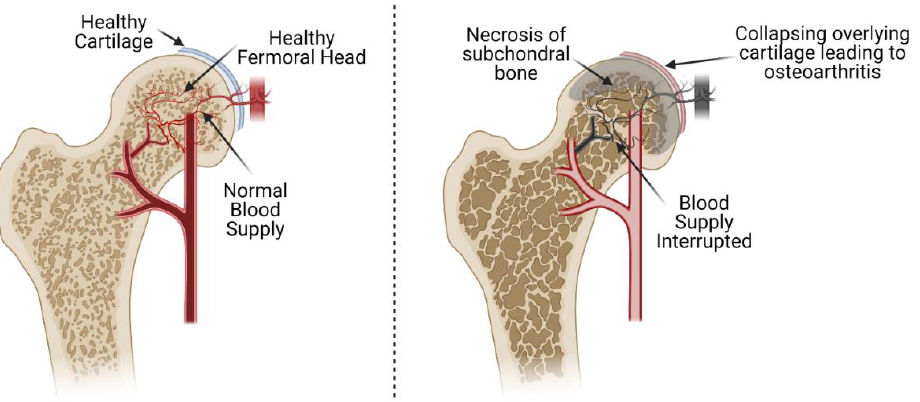
Figure 1. Avascular necrosis of the femoral head. The interruption of blood supply creates a hypoxic environment in the femoral head, leading to necrosis and collapse of the subchondral bone. This ultimately leads to collapse of the overlying cartilage of the femoral head and initiation of osteoarthritis of the femoral head and acetabulum.